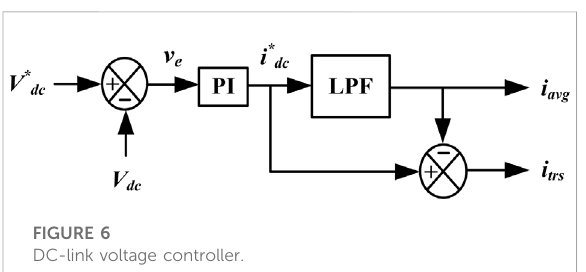
FIGURE 7 Conditions of the proposed